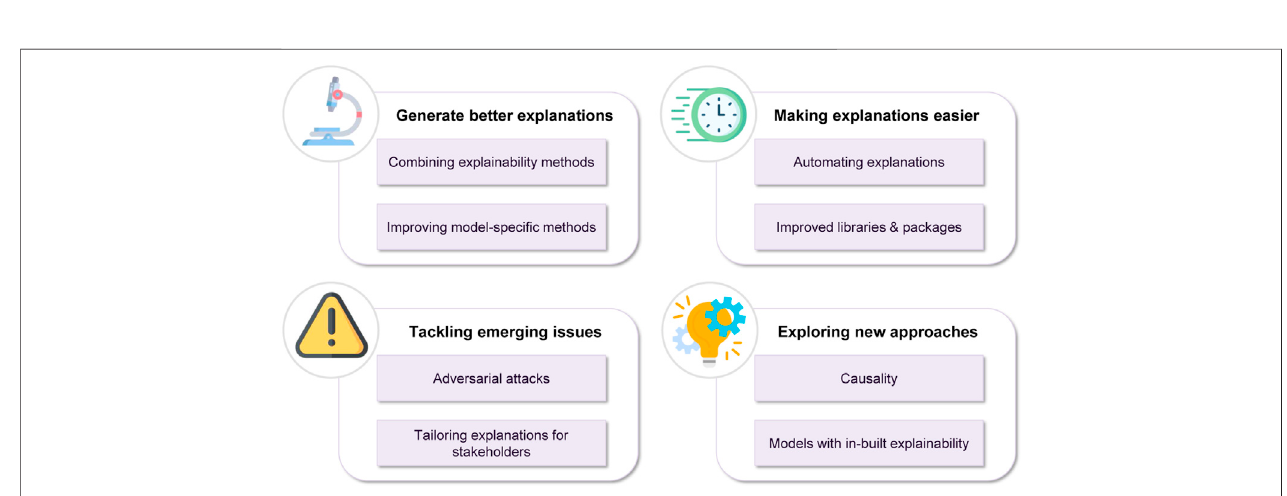
FIGURE 17 | Possible avenues for XAI